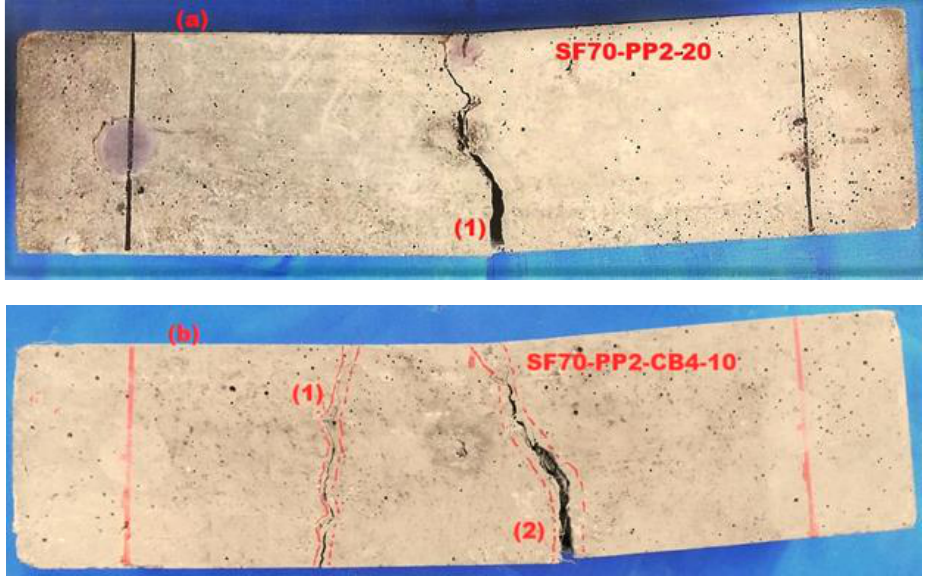
Figure 9. Single and multiple crack patterns of ( a ) SF70-PP2-20 ( b )